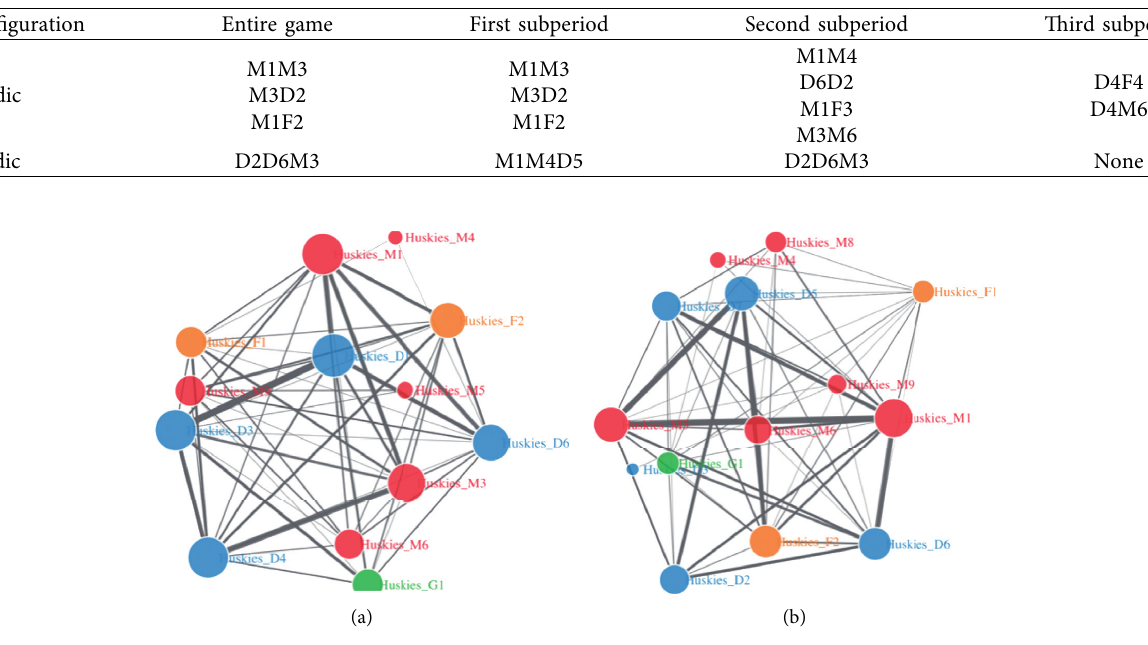
Figure 10: Match 8 (a) and Match 17 (b) passing network.